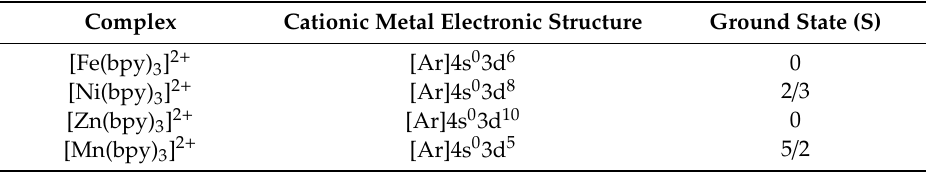
Table 2. The average length of coordinate bonds r Me-N , average values of angles (cid:94) N–Me–N and dipole moment of coordinate bonds µ b for the optimized structures with values of standard deviations for bonds length σ r and angles σ (cid:94)